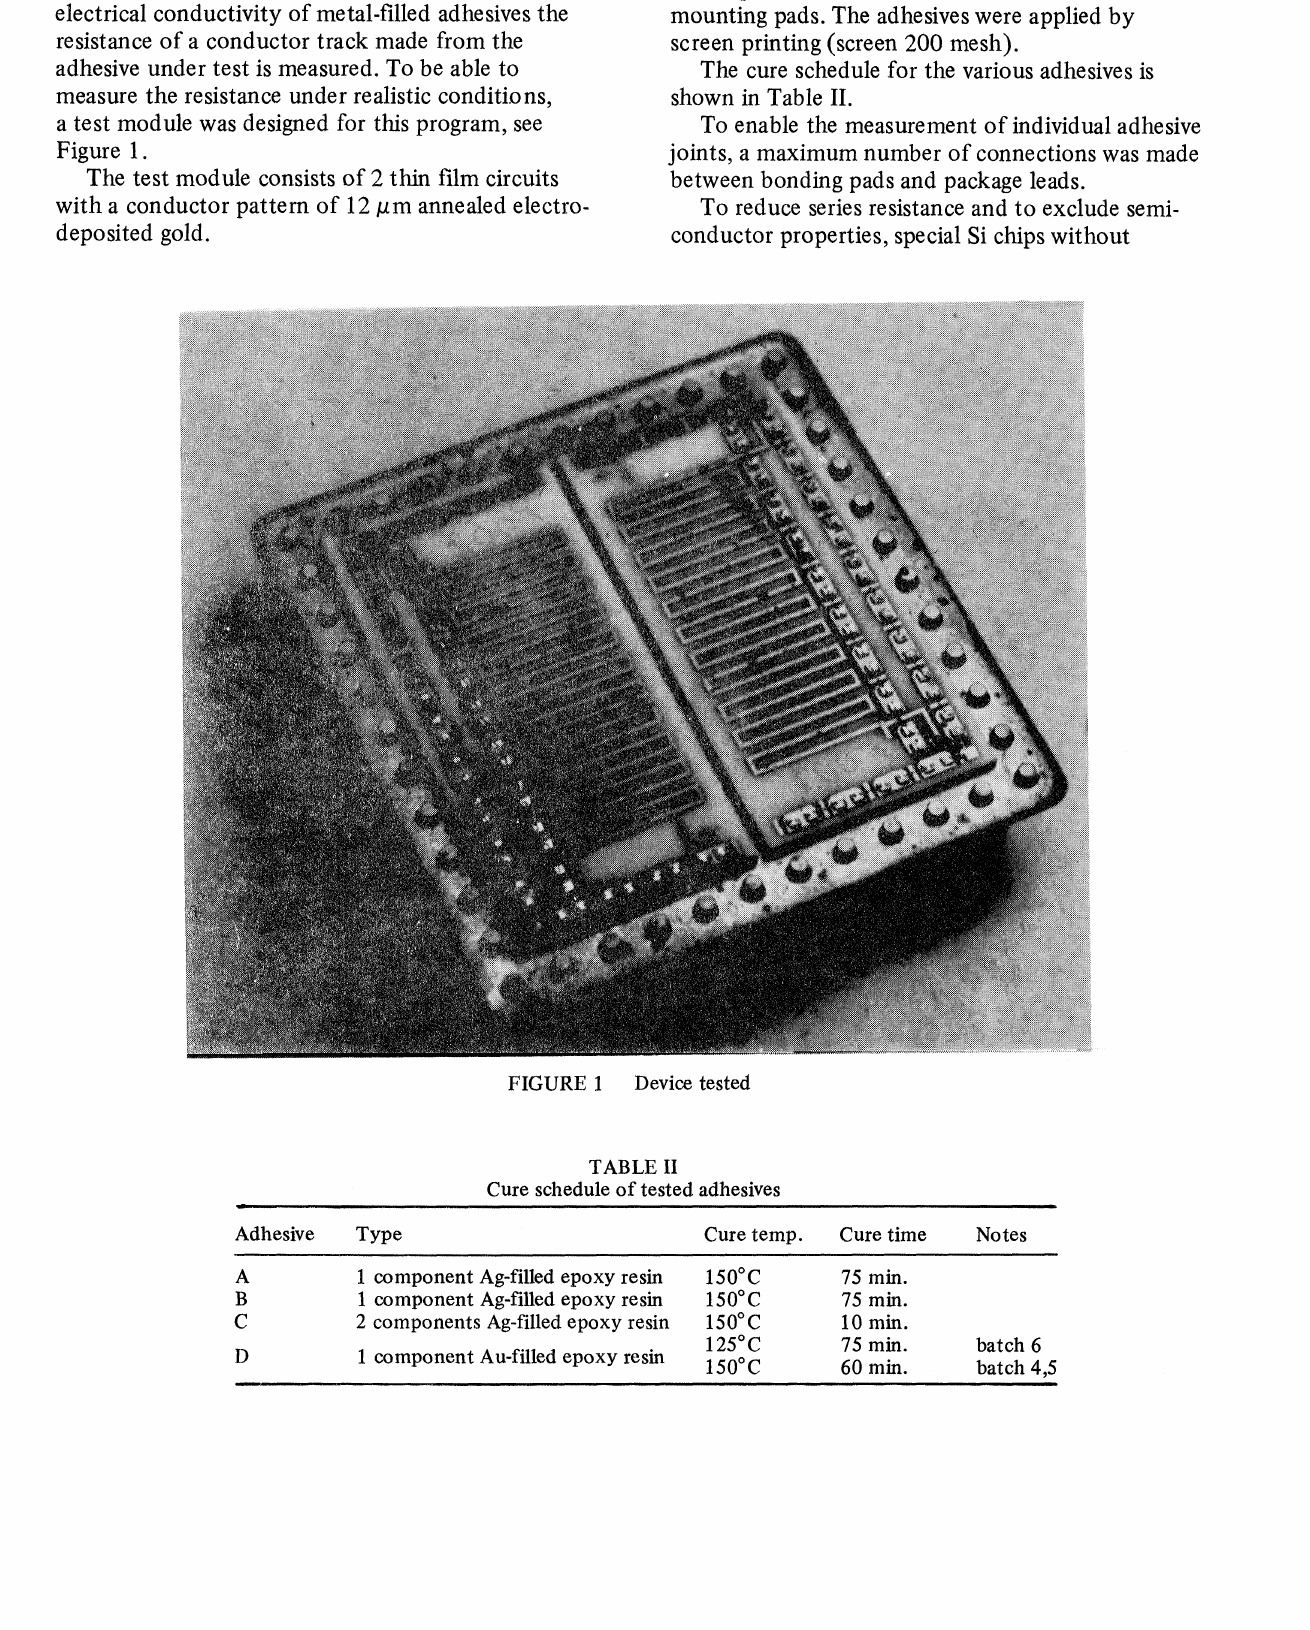
TABLE II Cure schedule of tested